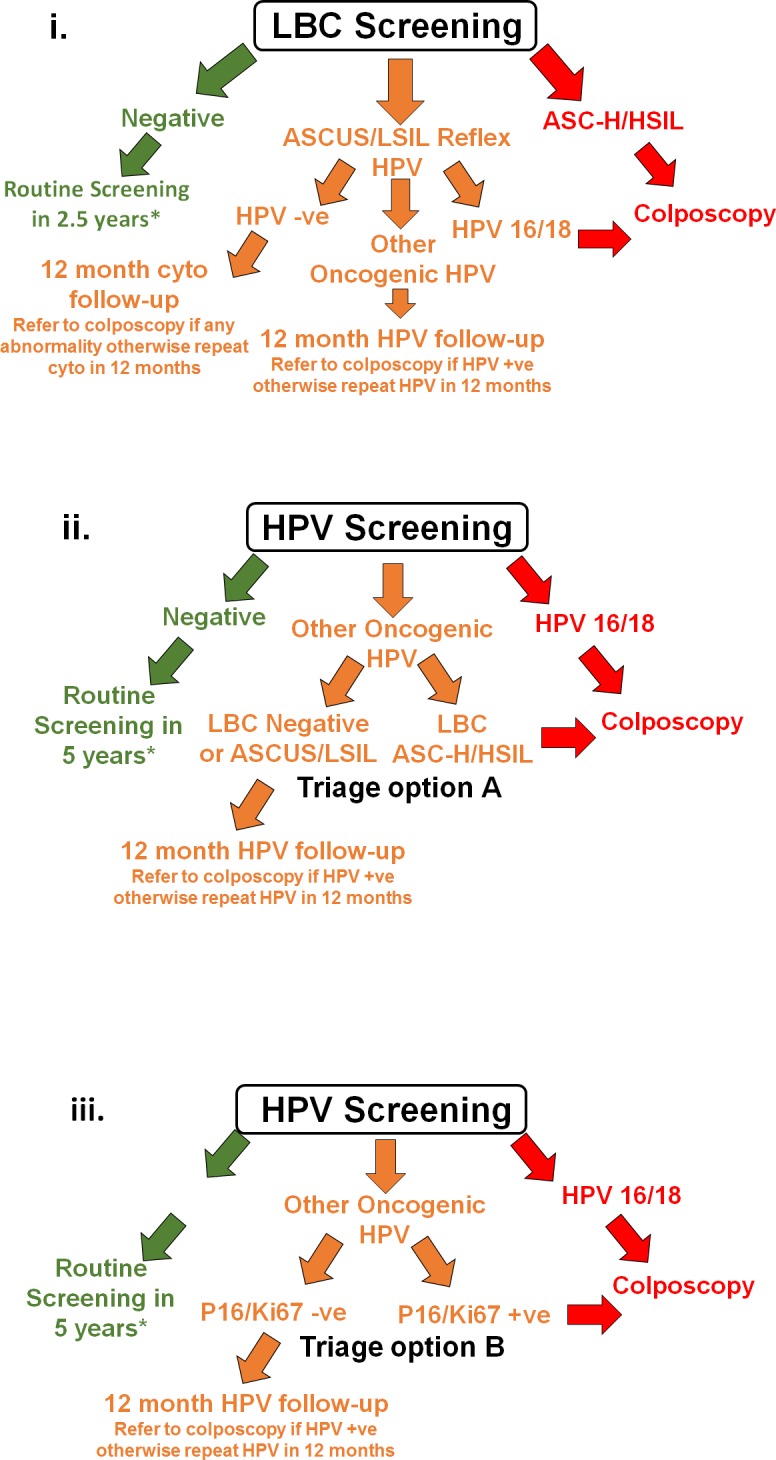
Schematic showing screening and management for each group in the trial.(i) LBC screening, (ii) HPV+LBC triage screening, and (iii) HPV+DS triage screening. *For more detailed management flowcharts, refer to S1 Text. −ve, negative; +ve, positive; ASC-H, atypical squamous cells–cannot exclude high-grade squamous intraepithelial lesion; ASCUS, atypical squamous cells of undetermined significance; cyto, cytology; HPV, human papillomavirus; HSIL, high-grade squamous intraepithelial lesion; LBC, liquid-based cytology; LSIL, low-grade squamous intraepithelial lesion.